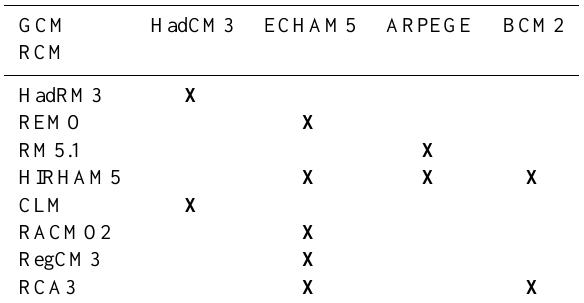
Table 2. Matrix of ENSEMBLES climate models with GCM–RCM pairings used for the climate models (GCM denotes global cli- mate model, RCM denotes regional climate model). From Seaby et al.